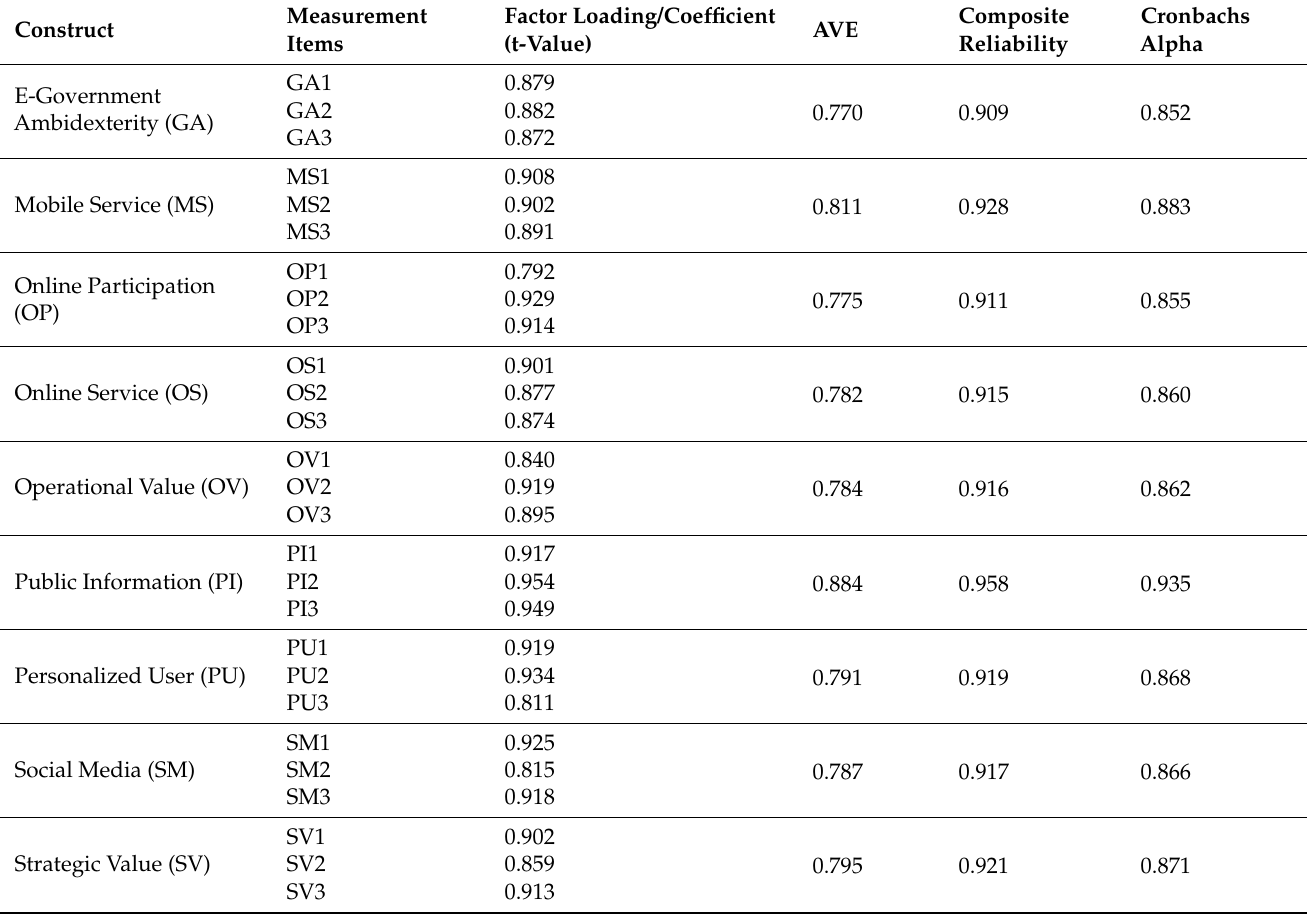
Table 4. Analysis of convergent reliability and